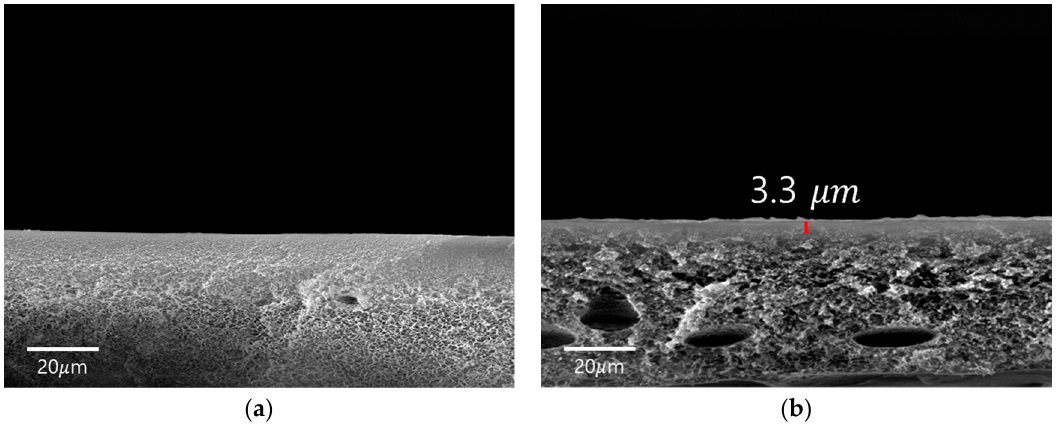
Figure 1. SEM images of ( a ) neat porous polymer support and ( b ) PEBAX-2533 / metal salt / Al salt membrane coated on porous polymer support.